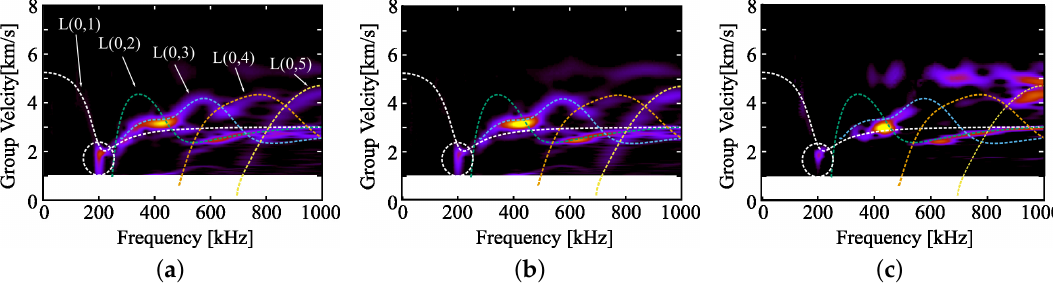
Figure 7. Comparison between wavelet transform of the ultrasonic signals and analytical group velocity dispersion curves of symmetric longitudinal mode guided wave; ( a – c ) represent the naked steel rod, heated specimen, and intact specimen,